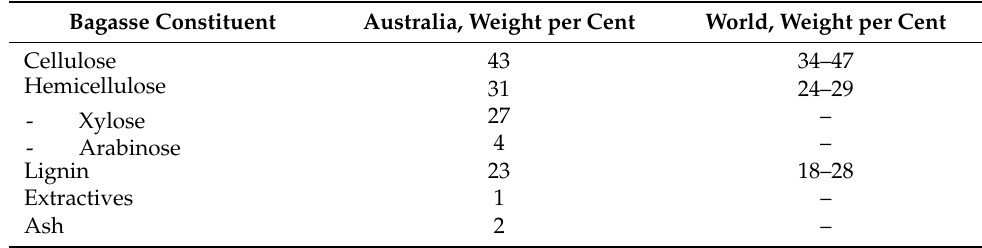
Table 2. A typical constitutive analysis of Australian and world bagasse fibre on a dry basis